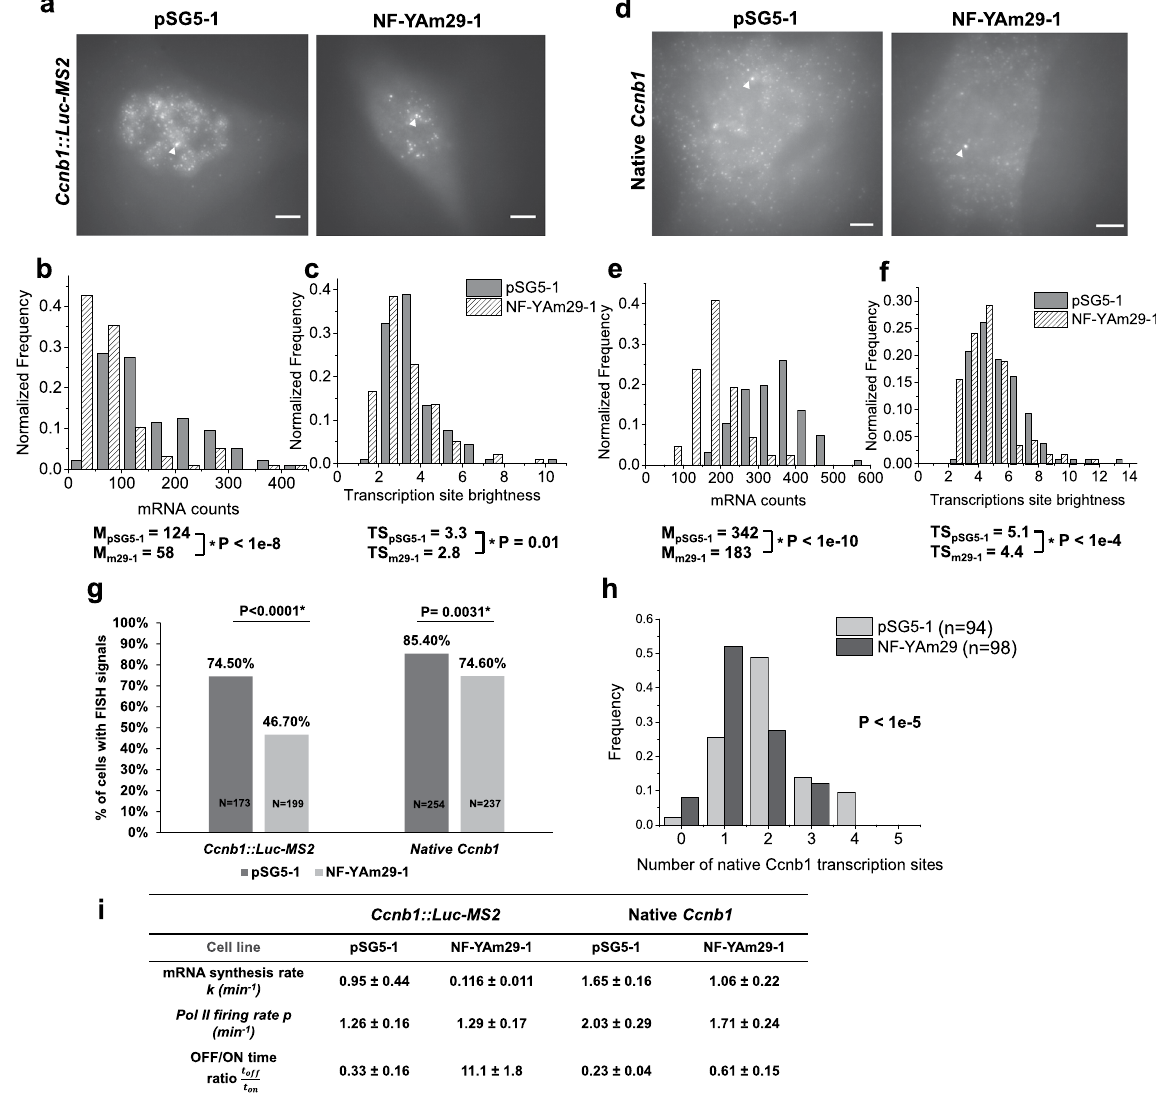
Figure 6. Effects of an NF-YA dominant negative mutant on Ccnb1 :: Luc - MS2 transgene expression and native Ccnb1 gene expression. ( a ) Representative single molecule RNA FISH images of the Ccnb1 :: Luc - MS2 transgene using MS2 probes in control pSG5-1 cells (stably transfected with the pSG5 vector) and in cells expressing the NF-YAm29 mutant. ( b , c ) Histograms and medians of mRNA counts ( b ) and TS brightness ( c ) of the Ccnb1 :: Luc - MS2 transgene. Measured cell number and TS number were 95 and 90 for control pSG5-1 cells, respectively, and were 96 and 96 for NF-YAm29-1 cells, respectively. ( d ) Representative single molecule RNA FISH images of the native Ccnb1 gene in control pSG5-1 cells and in cells expressing the NF-YAm29 mutant. In panels a and d, white arrowheads indicate the transcription sites. Scale bars: 5 µ m. ( e , f ) Histograms and medians of mRNA counts ( e ) and TS brightness ( f ) of the native Ccnb1 gene. Measured cell number and TS number were 96 and 130 for control pSG5-1 cells, respectively, and were 88 and 116 for NF-YAm29-1 cells, respectively. In panels b,c,e and f, asterisks ( * ) indicate statistically significant differences (p < 0.05) between control cells (pSG5-1) and cells expressing the NF-YAm29 mutant determined by student’s t-test (P values are shown in each plot). ( g ) Fractions of cells with Luc - MS2 mRNA FISH signals and native Ccnb1 mRNA FISH signals among control cells and cells expressing the NF-YAm29 mutant. Asterisks ( * ) indicate statistically significant differences (p < 0.05) between the experimental groups determined by Fisher’s exact test. In panels (a–g), FISH images from one experiment using Ccnb1 exon probes were analysed. ( h ) Frequencies of detected active TSs of the native Ccnb1 gene using Ccnb1 intron FISH probes among control cells and cells expressing the NF-YAm29 mutant (see images in Supplementary Fig. S17). Images were taken from two FISH experiments. Student’s t-test was used to determine the statistical significance (P value is shown in the plot). ( i ) Table summarizing calculated mRNA synthesis rates, Pol II firing rates and “OFF”/“ON” time ratios of the Ccnb1 :: Luc - MS2 transgene and the native Ccnb1 gene in control cells and cells expressing the NF-YAm29